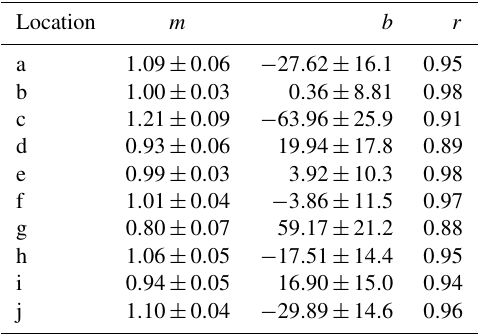
Table 3. Regression statistics for the daily forecasts. Note that the slope m would ideally be equal to 1, the intercept b would be equal to 0 and the correlation coefficient r would be 1. Standard errors are provided for both m and b